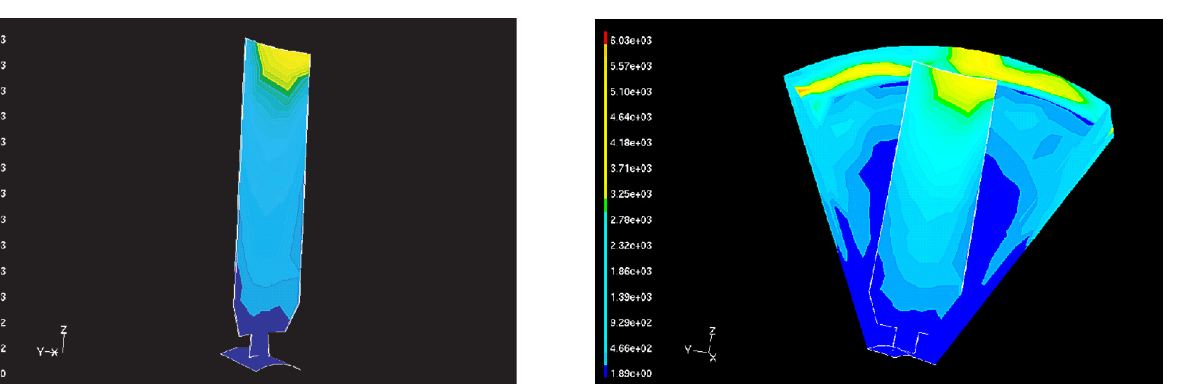
Figure 14: Dynamic pressure on the pressure side without radiator (unit in Pascal).